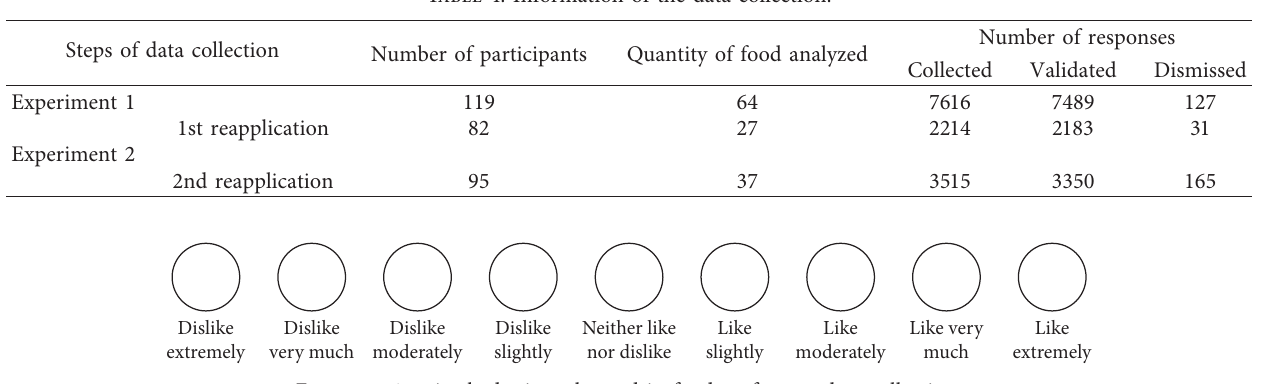
Table 4: Information of the data